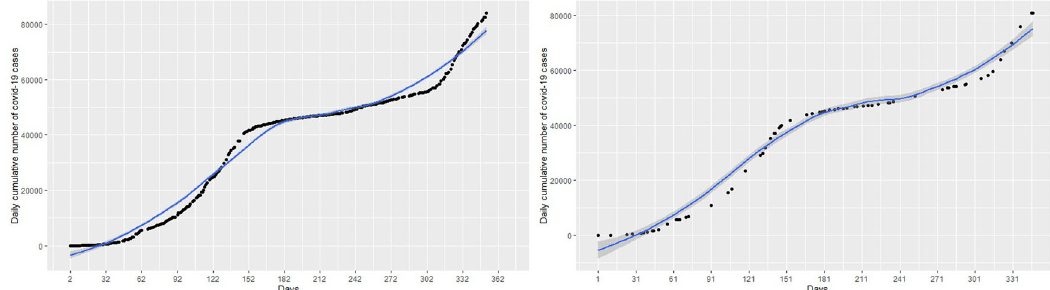
Figure 2. Plots of the training dataset (left panel) and test dataset (right panel) for cumulative coronavirus disease 2019 (COVID-19)